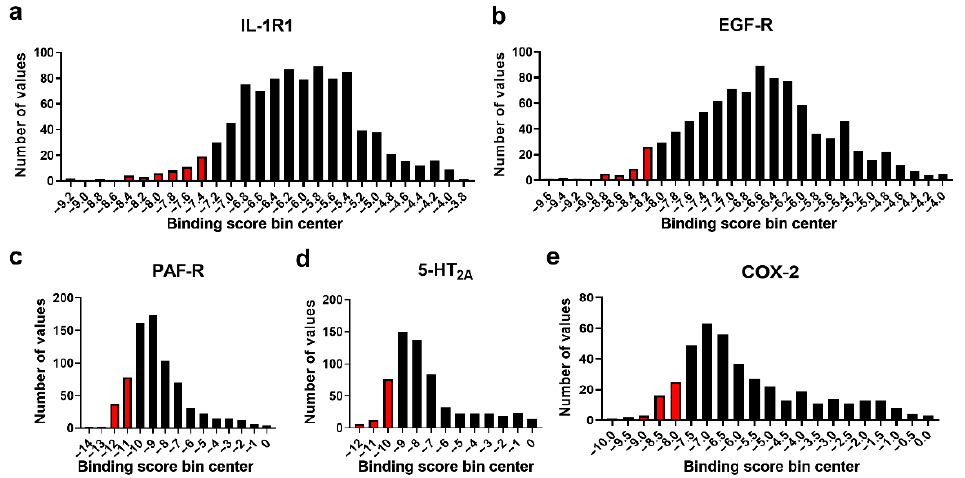
Figure 5. Results of the target-based virtual screening. Histograms analyzed the frequency distribution of the binding scores for each target. The X -axis represents the bin center of the binding score ranges, and the Y -axis represents the number of values. Red bars indicate values with the lower 5th percentile. Molecular docking results for ( a ) IL-1R1; ( b ) EGF-R; ( c ) PAF-R; ( d ) 5-HT 2A ; ( e ) COX-2.